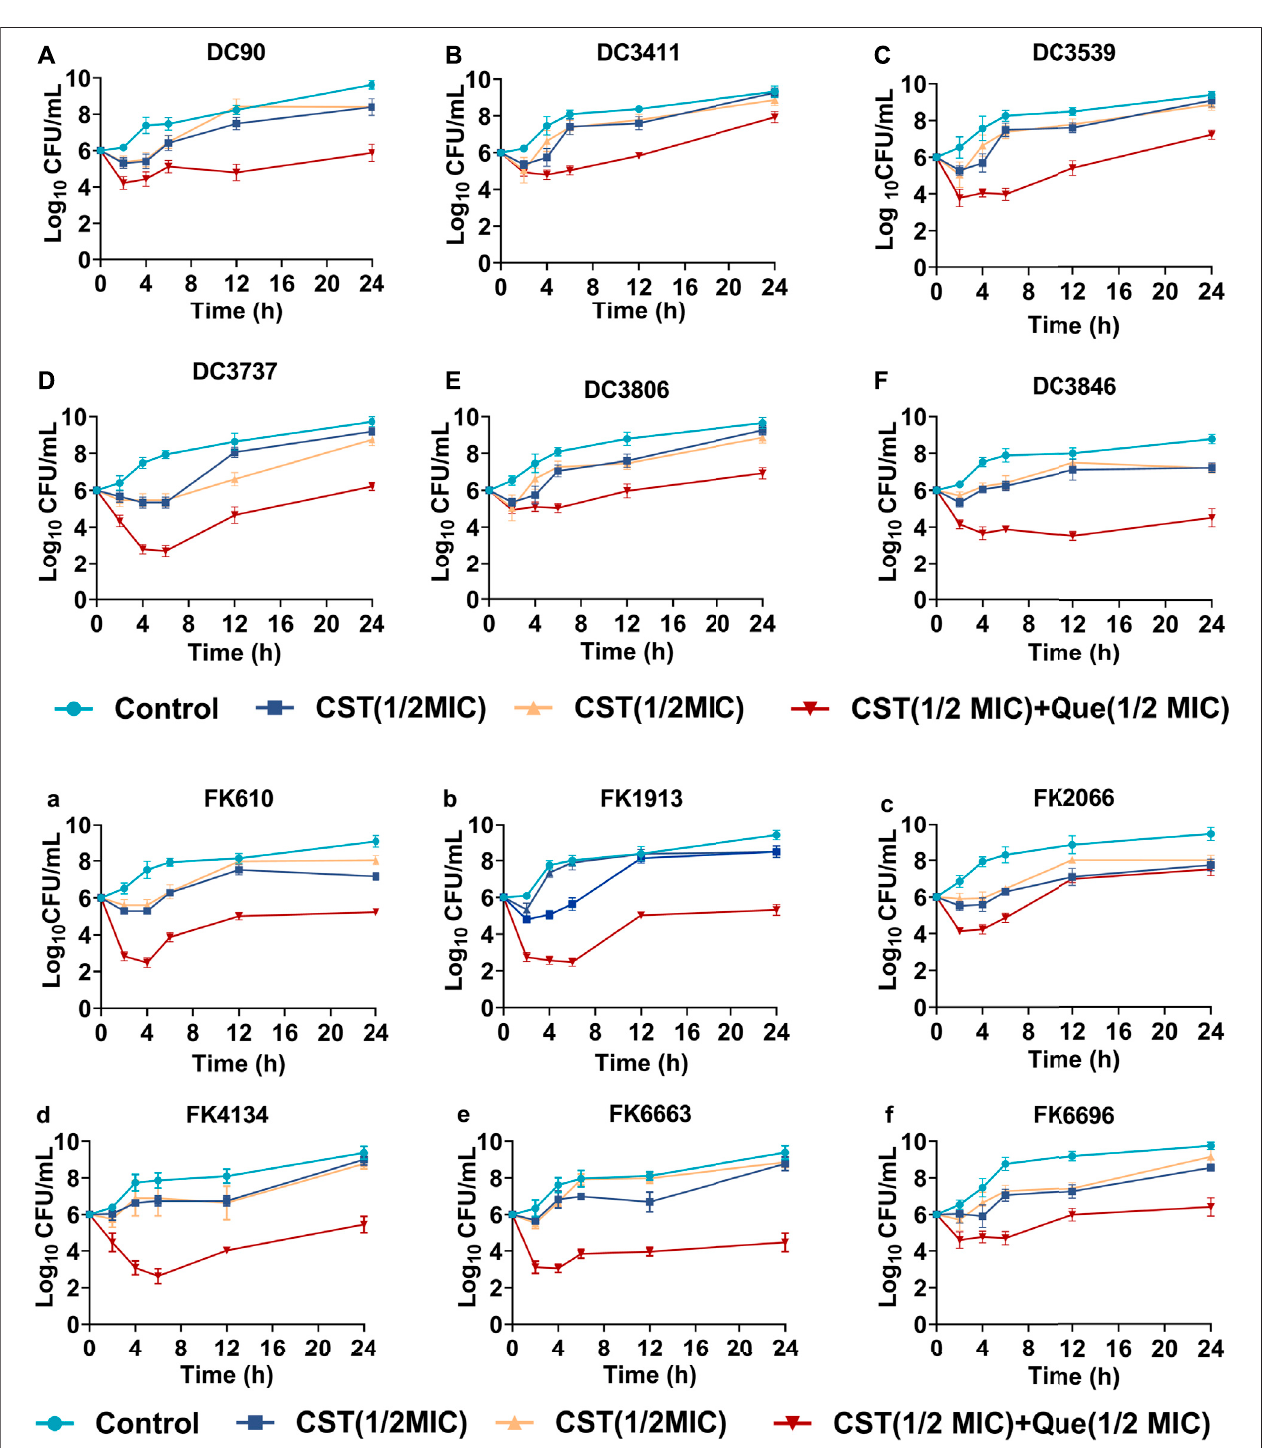
FIGURE 1 | Bactericidal kinetics of various treatments against the colistin-resistant E. coli and K. pneumoniae (A – F) Quanti fi ed log10 CFU/mL of various colistin- resistant E. coli strains at different time intervals after being exposed to various treatments (G – L) Quanti fi ed log10 CFU/mL of various colistin-resistant K. pneumoniae strains at different time intervals after being exposed to various treatments.